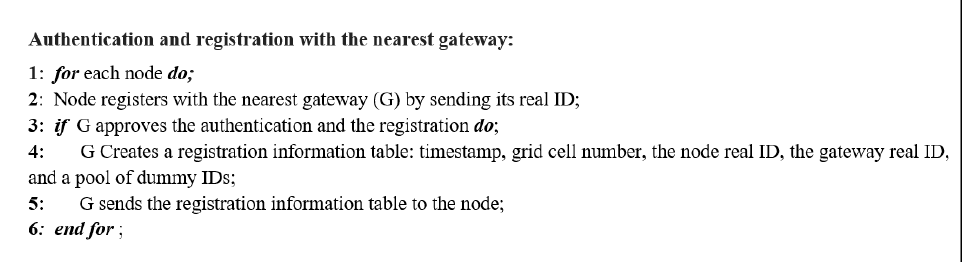
Figure 3. Authentication and registration with the nearest gateway